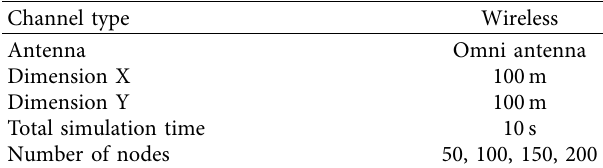
Table 4: Simulation parameters.